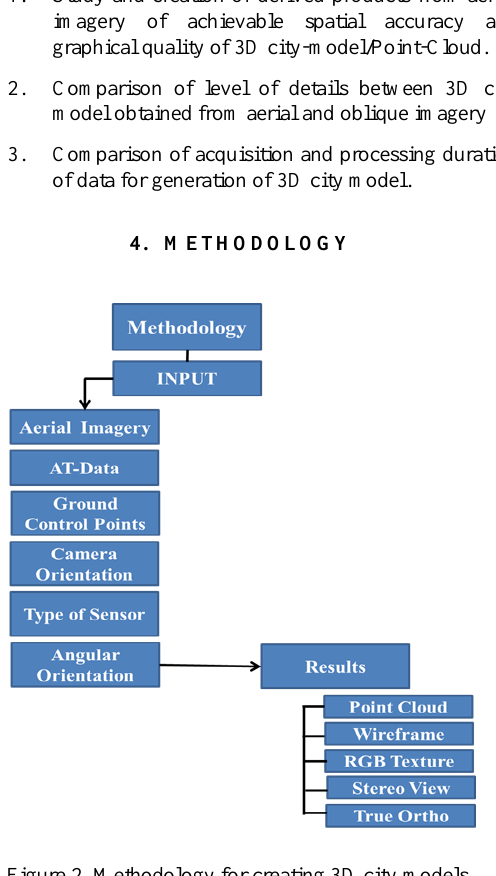
Figure 2. Methodology for creating 3D city